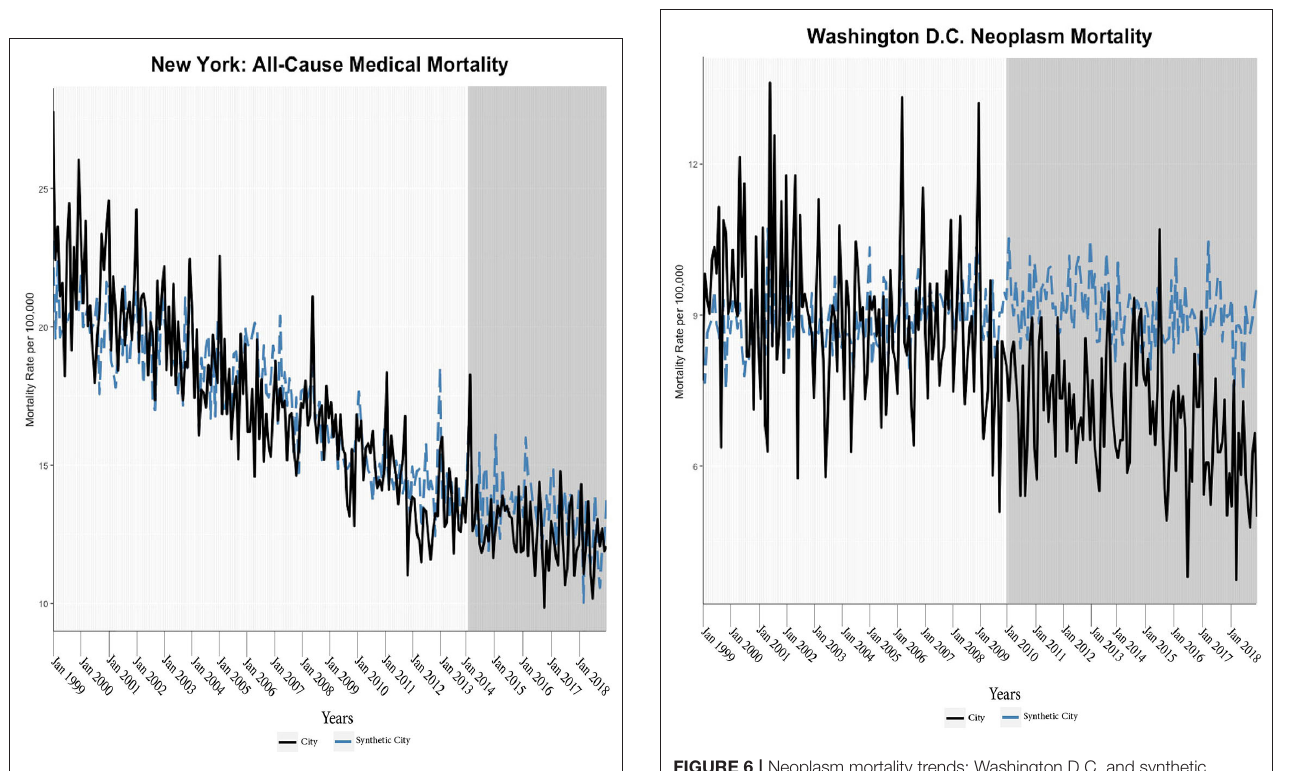
FIGURE 4 | All-cause mortality trends: New York and synthetic control city.